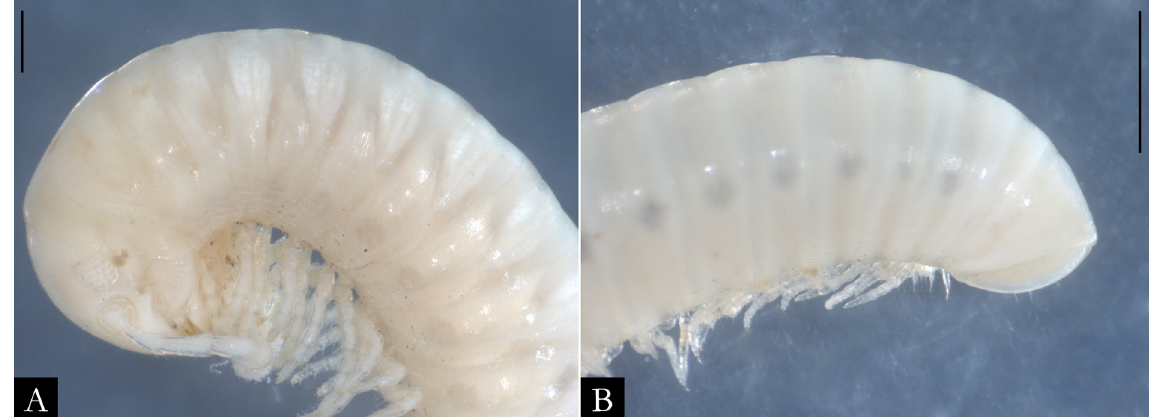
Fig. 115. Pseudonannolene rocana Silvestri, 1902, ♂ (NHMD), in lateral view. A . Anterior region. B . Posterior region. Scale bars = 1 mm.